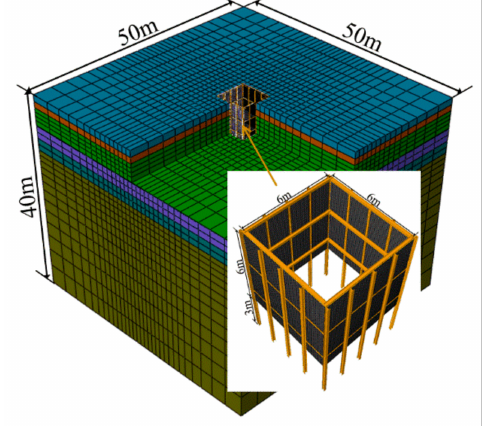
Figure 18. The structure of the calculation grids of the soil